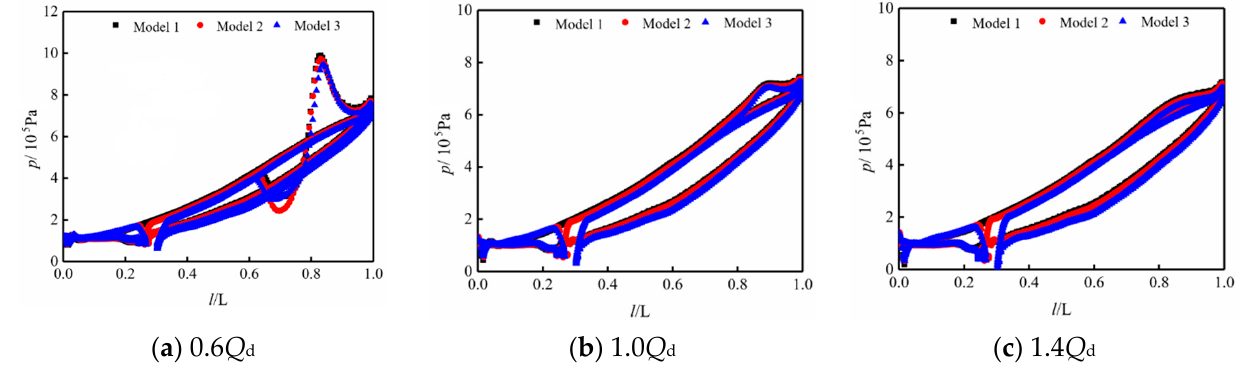
Figure 11. Surface velocity distribution of 50% impeller height.